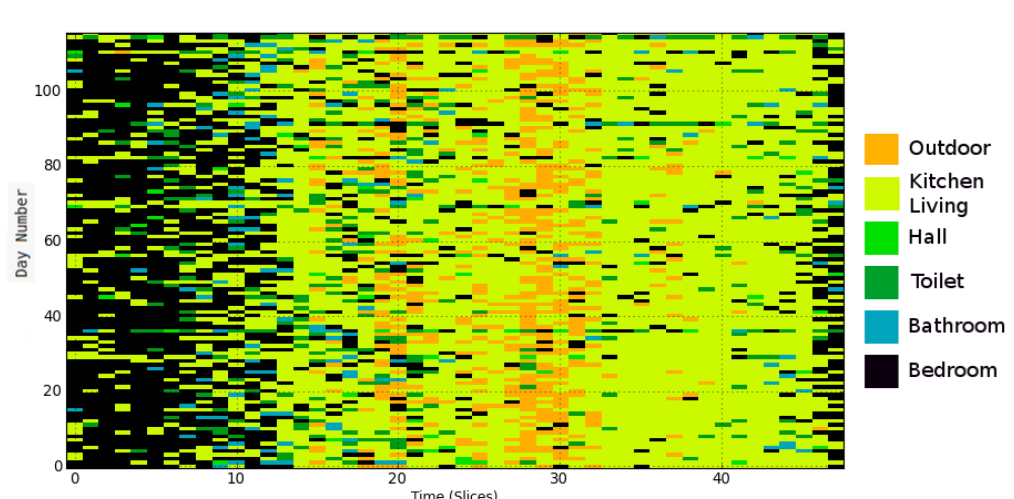
Figure 7. Location heat map for synthetic data with a 30-min resolution. This low resolution is for visualization purposes; normally, resolution is much higher (e.g., 60